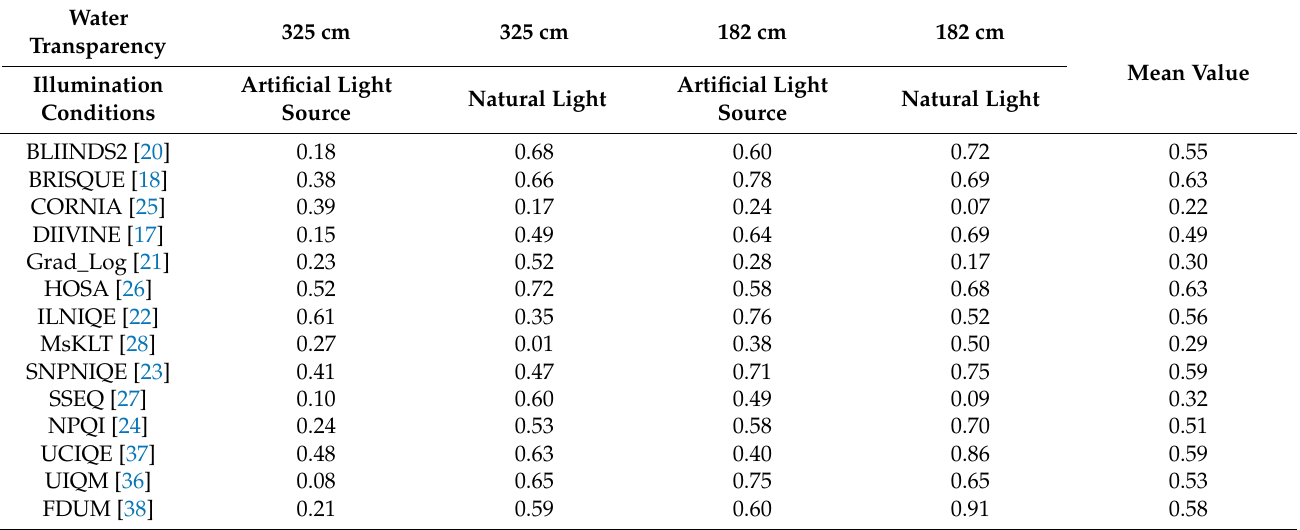
Table 5. PLCC between each method and MTF50 under different experimental conditions.